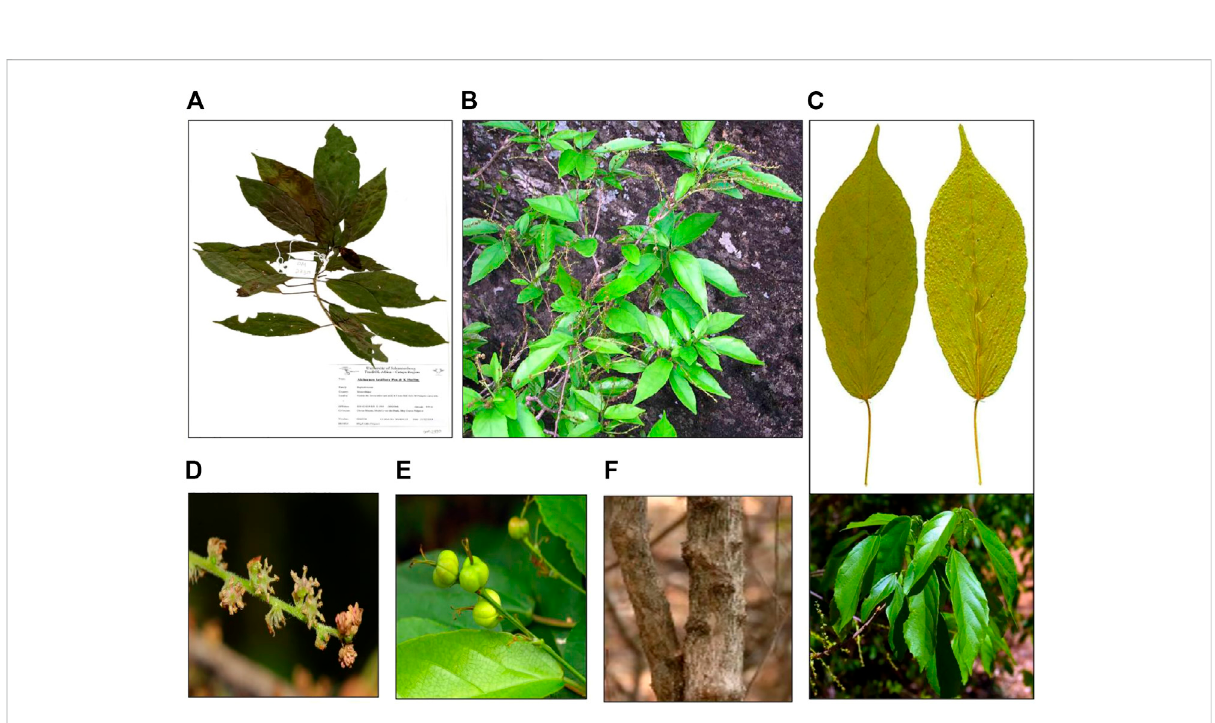
FIGURE 3 Morphology of A. laxi fl ora : herbarium specimen (A) , whole plant (B) , leaves (C) , in fl orescence (D) , fruits (E) , and stem (F) (https://www. zimbabwe fl ora.co.zw/).